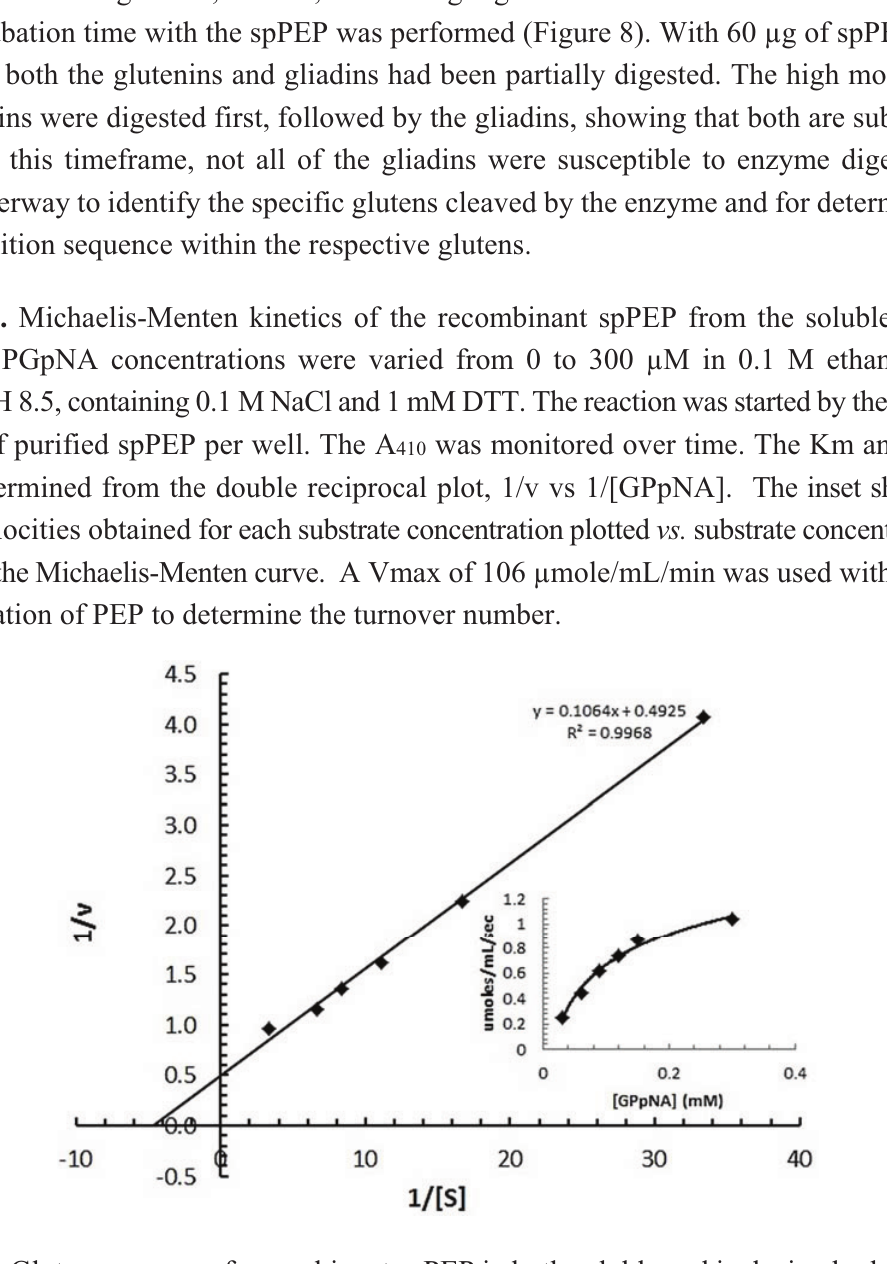
Figure 7. Glutenase assay of recombinant spPEP in both soluble and inclusion body lysates. Buffer was exchanged to 0.1 M ethanolamine, 0.1 M NaCl, pH 8.5. Reaction conditions